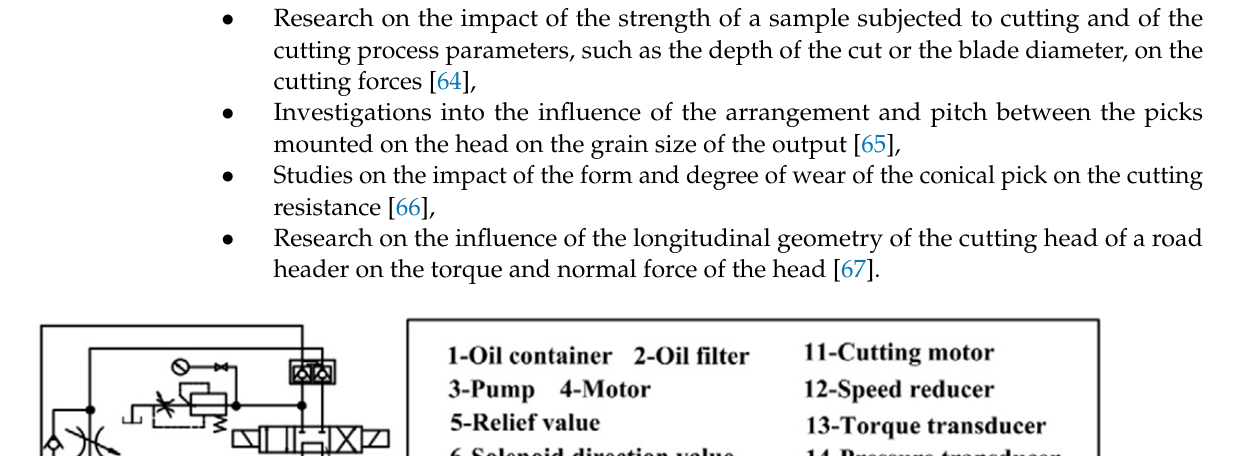
Figure 12. Full-size bench for testing the cutting process: ( a ). measuring cabin, ( b ). the test plate with a sample, ( c ). 250 kW drive system, ( d ). disc cutter head, and ( e ). cutting with a disc cutter head ( a – c) [69], ( d , e ) [31].